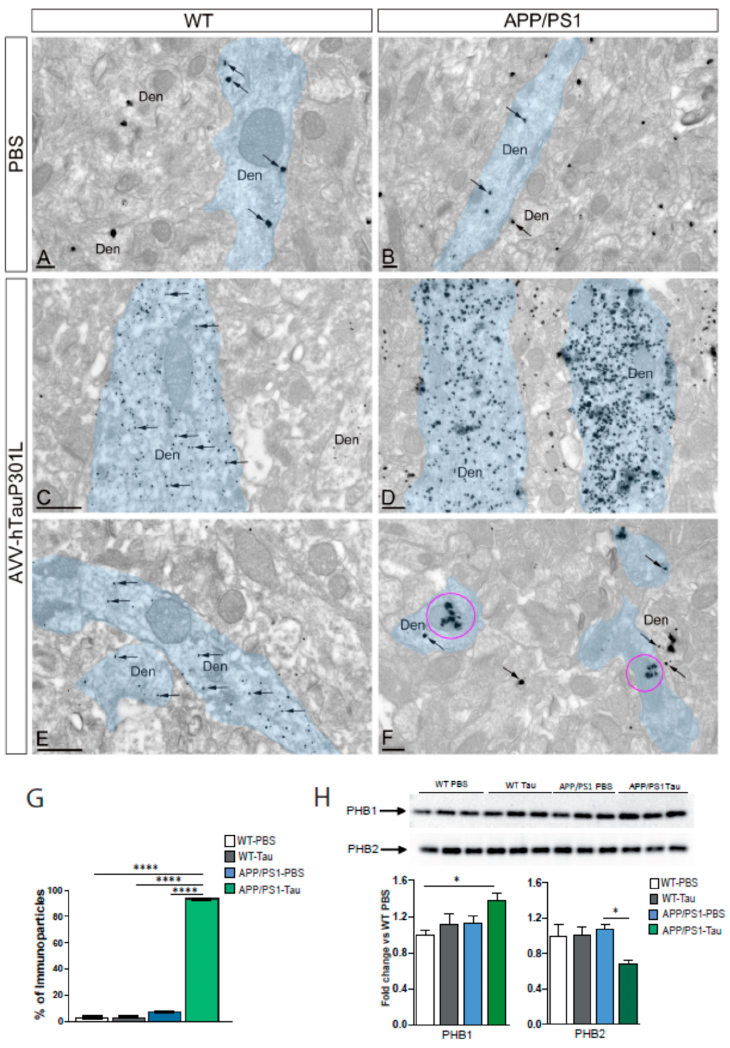
Figure 5. Electron micrographs showing the distribution of immunoparticles for tau in the CA1 region of mice hippocampi using a pre-embedding immunogold technique. ( A , B ) In WT and APP/PS1 in control group (PBS), few immunoparticles for tau (arrows) were observed in the cytoplasm of dendritic shafts (Den) of pyramidal cells (pseudo coloured in blue). Immunoparticles for tau were not associated with mitochondria present in the shafts. ( C , D ) In WT and APP/PS1, in AVV-hTauP301L group, many immunoparticles for tau (arrows) were observed in the cytoplasm of dendritic shafts (Den) of pyramidal cells (pseudo coloured in blue). However, only in APP/PS1, immunoparticles were mostly associated with mitochondria (purple circle, ( F )) but not in WT mice, where the mitochondria remain free of tau immunoparticles ( E ). Scale bars: ( A , B , D , F ): 200 nm; ( C , D ): 500 nm. ( G ) Histogram showing the quantification of tau immunoparticles in the dendritic mitochondria for each group of animals ( n = 3 animals/group). Error bars indicate SEM; p < 0.0001. ( H ) Hippocampal PHB1 and PHB2 levels assayed by immunoblotting in WT, and APP/PS1 mice injected with the AAV9-hTauP301L ( n = 4–5). Equal loading of the gels was assessed by Ponceau staining. Two-way ANOVA and Tukey’s post-hoc test was used for statistical analyses. * p < 0.05, **** p <